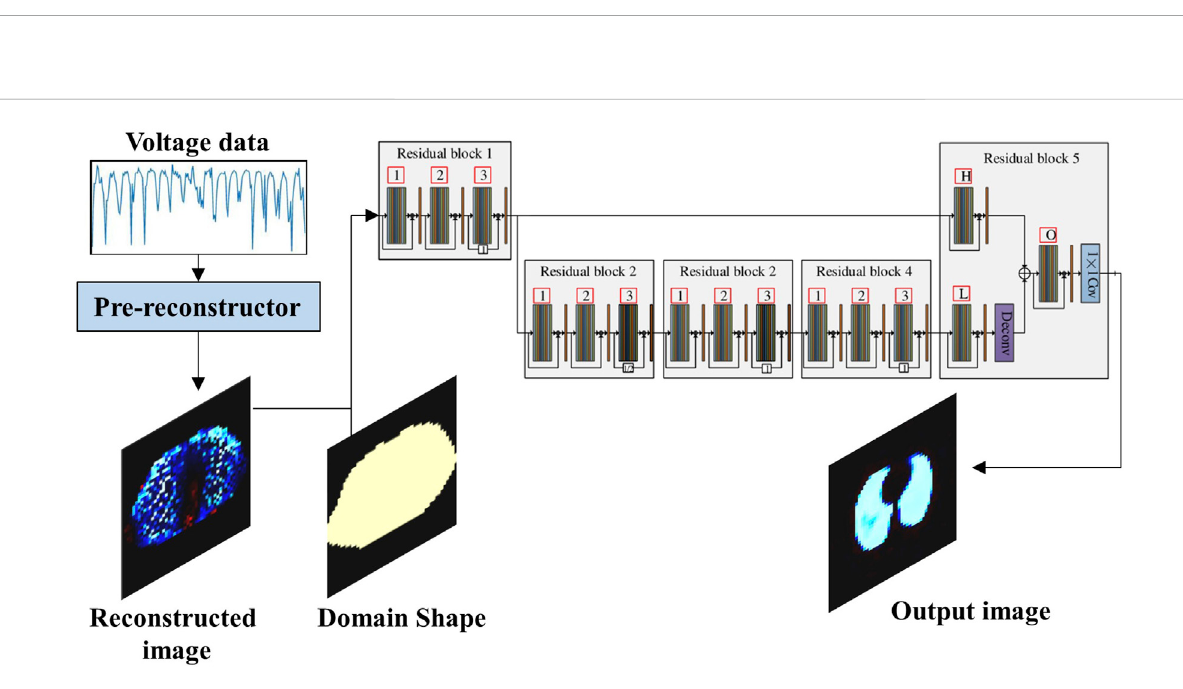
FIGURE 4 DeepD-BarusestheinitiallowqualityconductivityimageobtainedbytraditionalD-BarandsubsequentlycombinestheU-Nettopost-process the image and obtain a high quality static EIT image (Hamilton et al.,